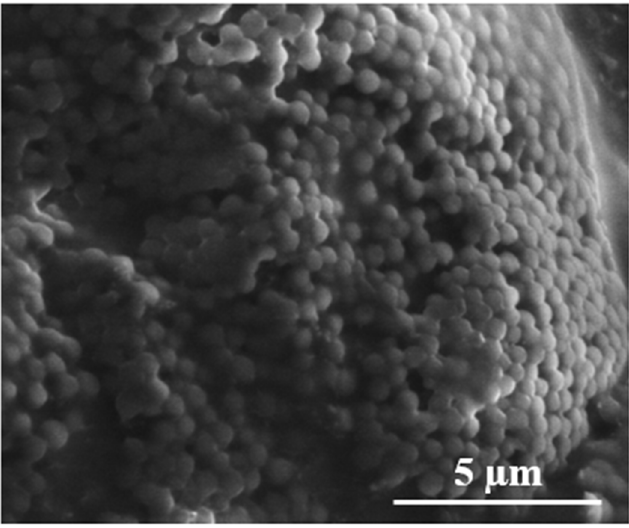
Figure 3. SEM image of polyNIPAm microspheres synthesized using a thermal initiator (T1).